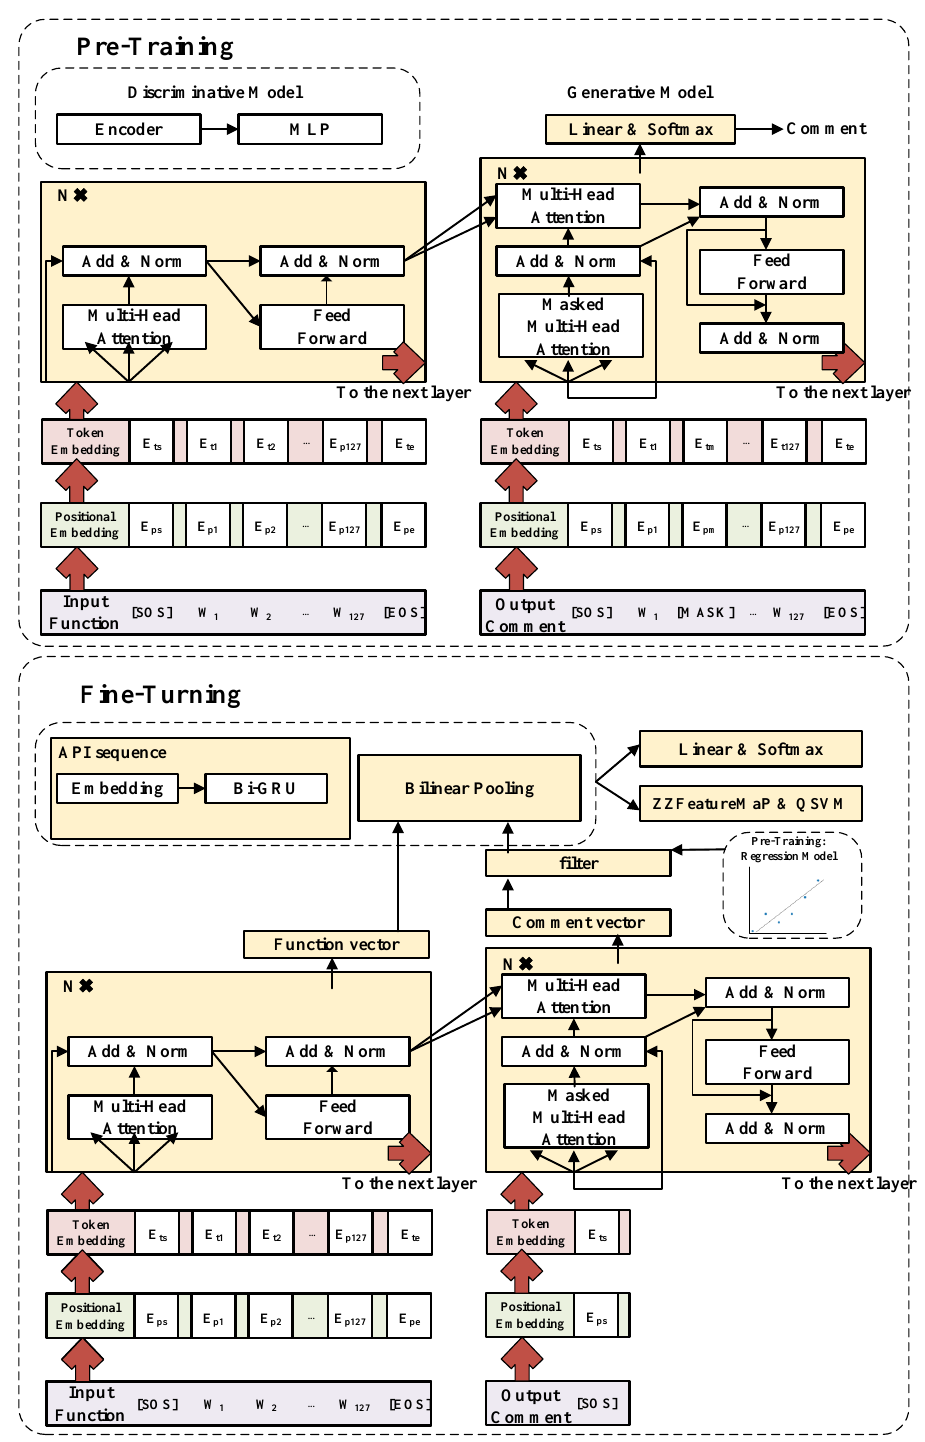
Figure 4. Overview of